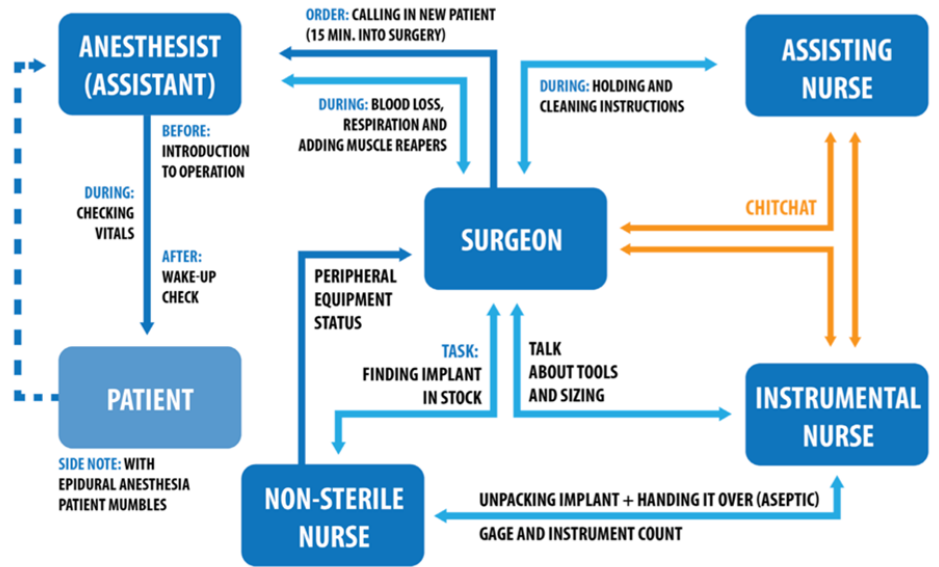
Figure 9. Information flow diagram within the OR team members.